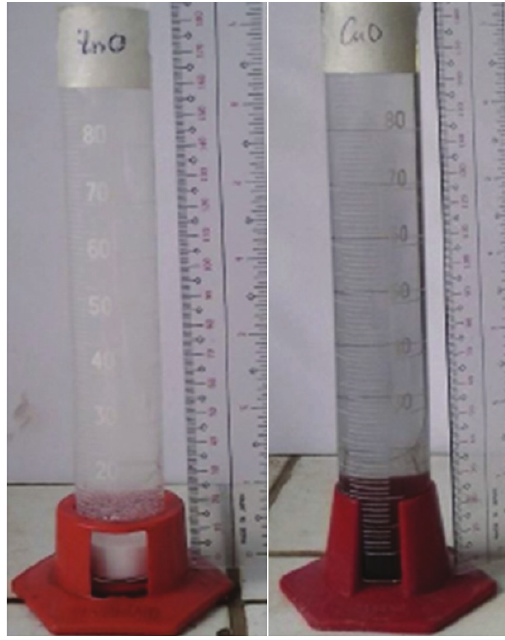
Figure 3. Stability of ZnO and CuO in acetone.